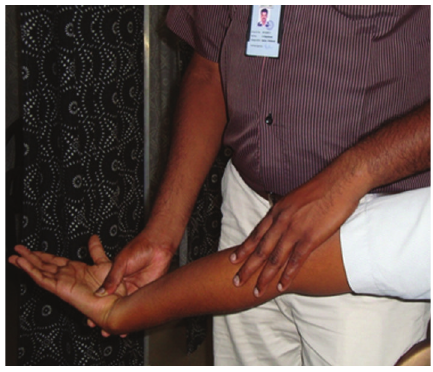
Figure 2: Mill’s